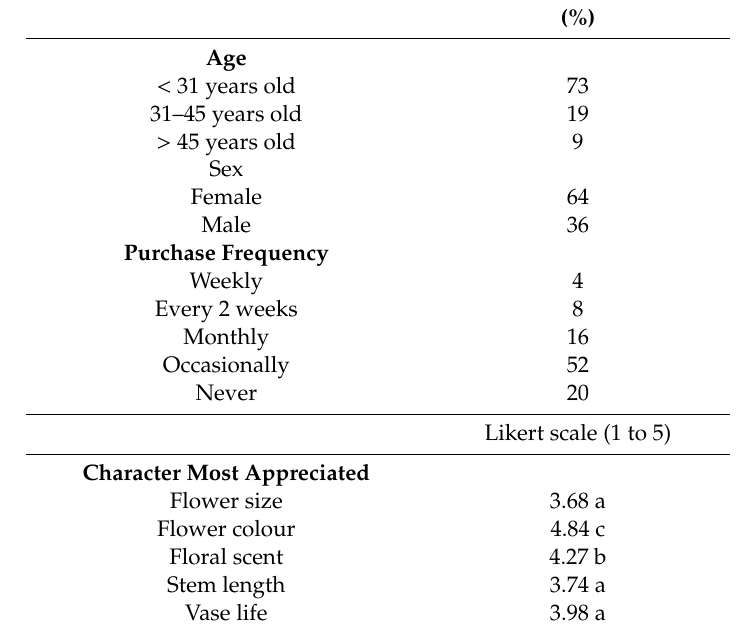
Table 1. Distribution of the population ( n = 80) that participated in the sensorial analysis of three cut flowers, considering age, sex, purchase frequency, and their opinion about the character most appreciated when buying or looking at flowers. Di ff erent small letters indicate significant di ff erences in ANOVA followed by a Tukey’s post hoc test ( p ≤